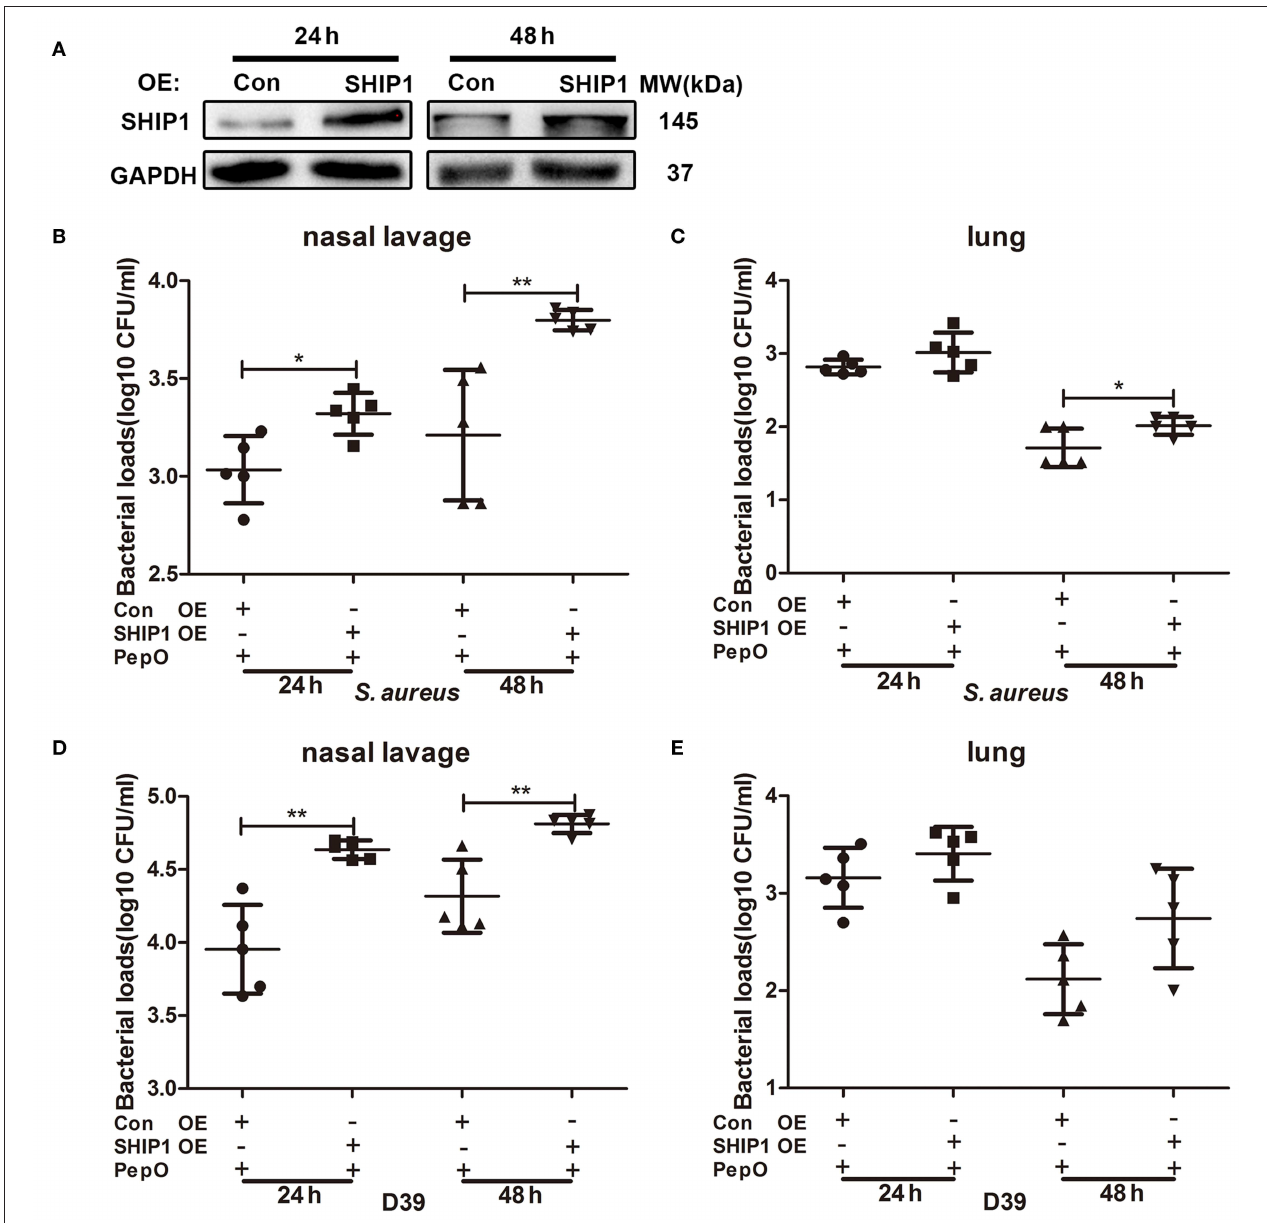
FIGURE 5 | The enhanced clearance of S. aureus and S. pneumoniae in PepO-treated mice is associated with the down regulation of SHIP1. (A) C57BL/6 mice were transiently transfected with pHBLV-CMV-SHIP1 plasmid or pHBLV-CMV-MCS control plasmid via intranasal administration for 24 and 48h. The effective over-expression of SHIP1 was determined by WB analysis. (B–E) After transfected with pHBLV-CMV-SHIP1 plasmid or pHBLV-CMV-MCS control plasmid, mice were intranasally administrated with PepO for another 24h followed by an intranasal infection of S. aureus (B,C) or D39 (D,E) for 24 and 48h. The number of viable S. aureus or D39 in nasal lavage fluids and lungs were determined. Data are shown as averaged ( ± SD) bacterial loads of at least five mice per group from one representative experiment of two. Statistical analysis was performed by student’s t -test. ** p < 0.01, * p < 0.05, OE, over-expression; Con,